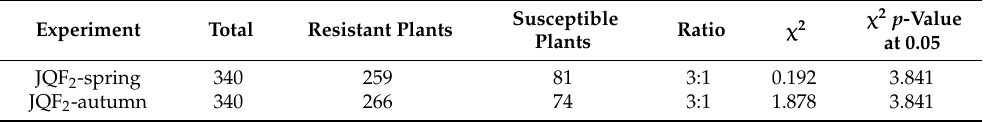
Table 1. Number of individual plants were identified as clubroot resistance and susceptible from F 2 population were screened in the spring and autumn seasons in the field trials after artificial inoculation with clubroot spores (10 7